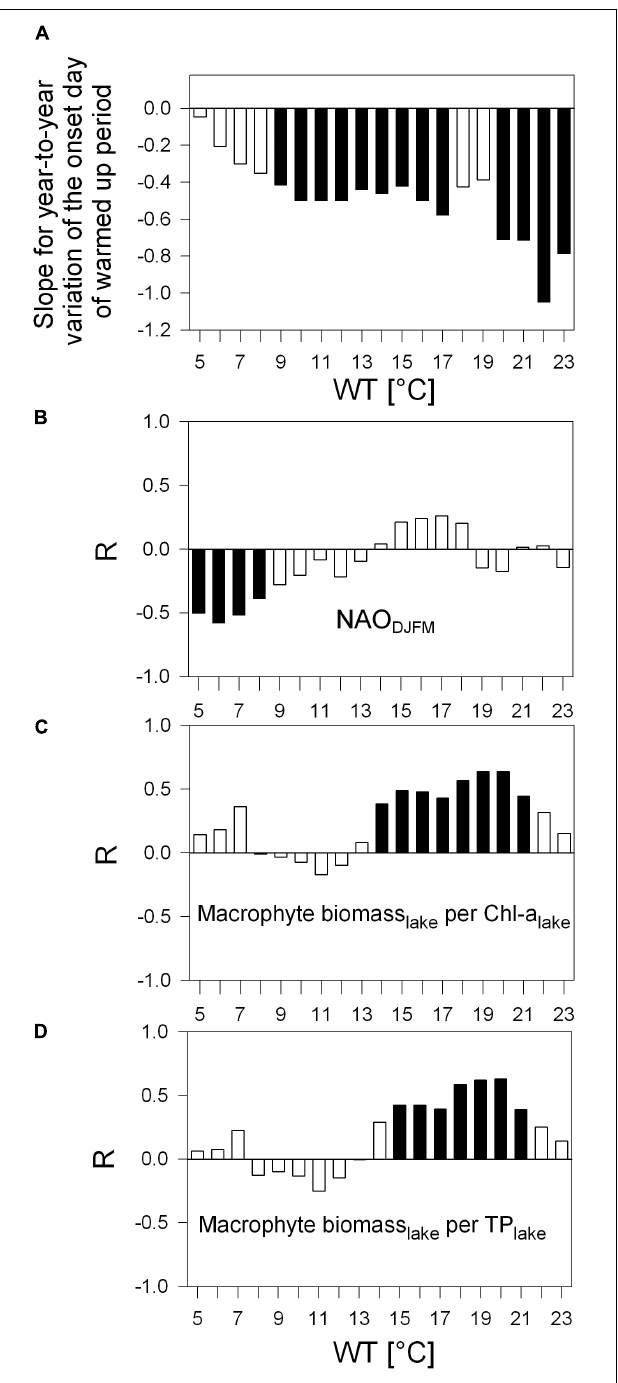
FIGURE 6 | Same as for Figure 5 with (A) as bar-chart and (B–D) as correlograms, but in panel (A) with slopes for the first day above a WT values from 5 ◦ C to 23 ◦ C (JD of the onset). (B–D) Correlograms for Pearson correlation between detrended year-to-year variation of JD onset shown in panel (A) and the NAO DJFM -index (B) , detrended ratio of macrophyte biomass (per lake) to Chl- a (per lake, C ) and detrended ratio of macrophyte biomass (per lake) to TP (per lake, D ). Black columns indicate p < 0.05. Examples of most significant R -values in panels (B–D) are displayed in scatter plots ( Figures 7D–F ); JD, Julian